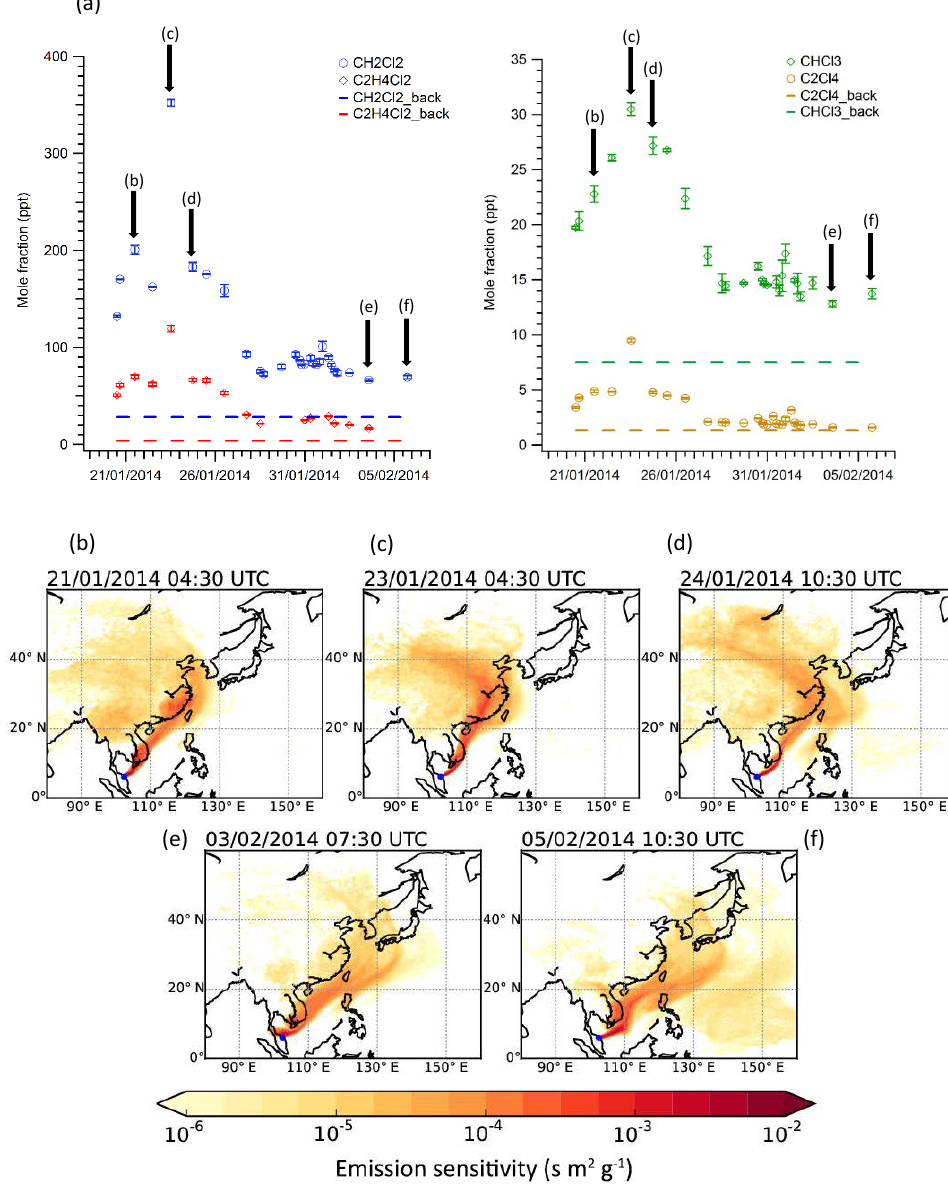
Figure 3. Panel (a) : ole fractions (ppt) of the four chlorinated VSLSs in air samples collected at Bachok in January/February 2014. Strongly enhanced levels of all four compounds were seen for a 7-day period at the beginning of the campaign (20–26 January). Also shown (dashed line) are the approximate median background concentrations in the remote marine boundary layer in 2012 (from Carpenter et al., 2015). Lower panels (b–f) : NAME footprint maps indicating the likely origin of the air sampled at Bachok. During the pollution episode ( b : 21 January; c : 23 January; d : 24 January), the samples would have been heavily impacted by emissions from the East Asian mainland, whilst this influence is much reduced during the cleaner, non-polluted periods ( e : 3 February; f : 5 February). Note that even after the main pollution event, the abundance of the VSLSs remain significantly above true background levels for much of the time, suggesting a widespread influence from industrial emissions on a regional scale. The location of Bachok is indicated with a blue circle (see also Fig.